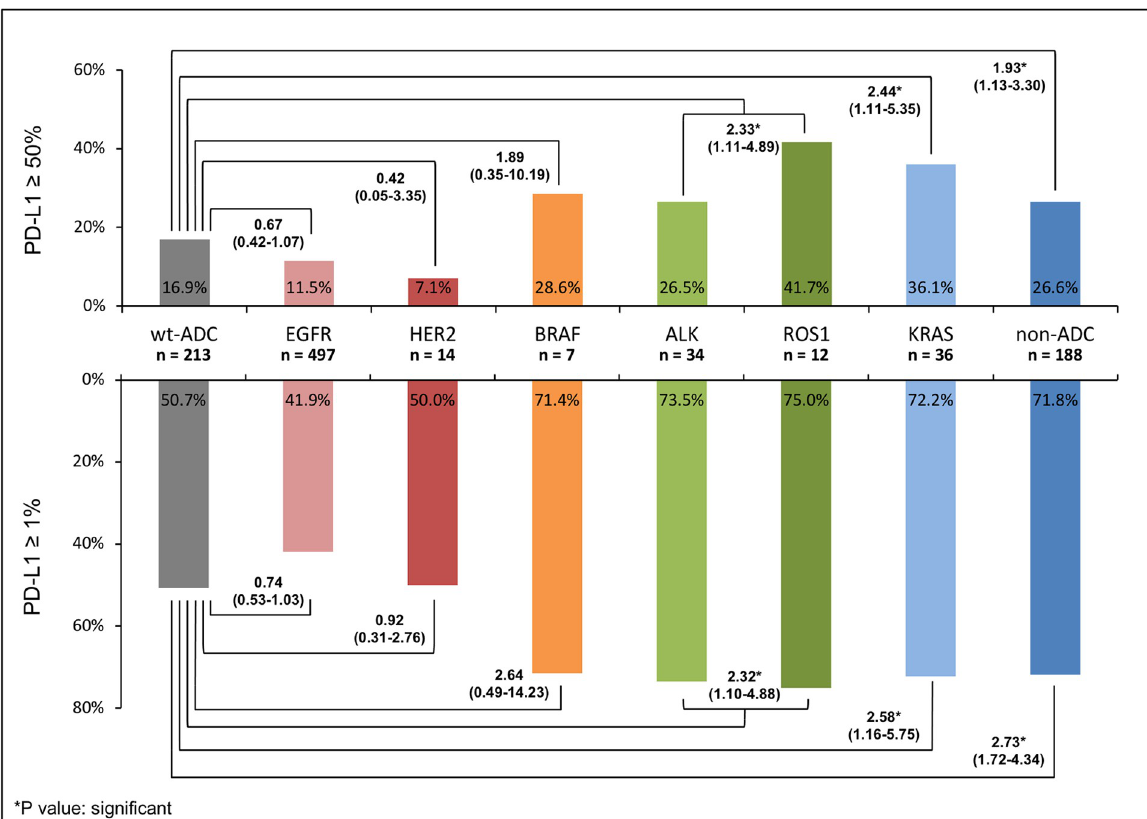
Fig 2. Various impacts of driver mutations on the PD-L1 expression of